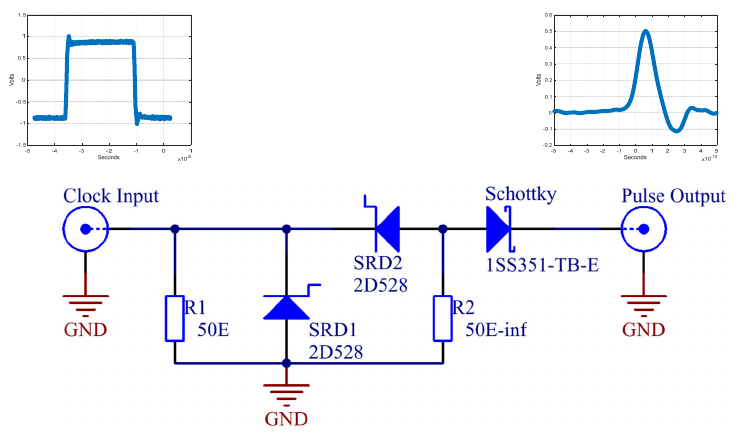
Figure 3. Proposed pulse generator with two SR diodes. The above schematics are measured signals at input and output,